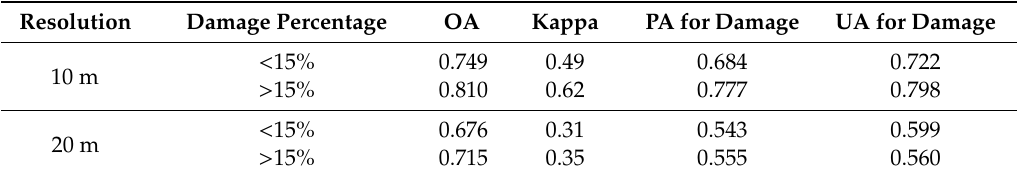
Table 6. Accuracy assessment of binary classification for S2 images using the SVM algorithm. 15% < the second damage percentage of each resolution image <